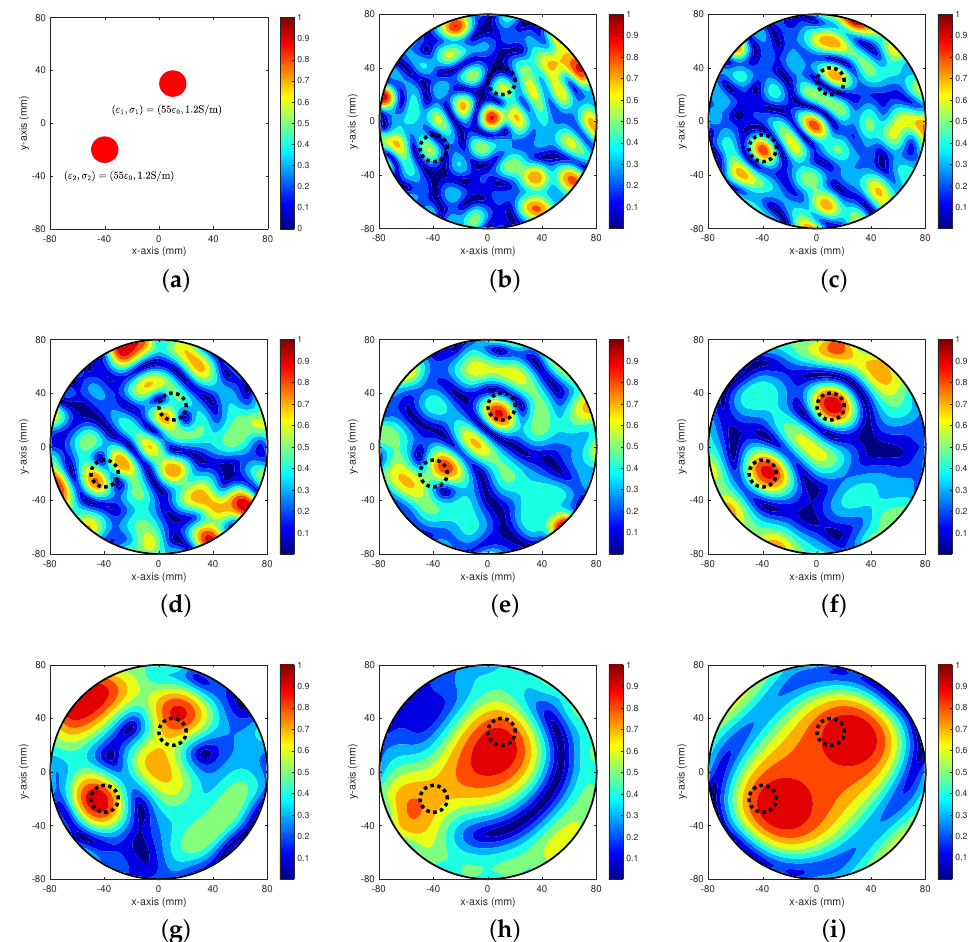
Figure 3. (Example 2) Maps of F BS ( r , n ) . Black-colored dashed lines describe the boundaries of ob- jectives. ( a ) Small objective, ( b ) n = 1, ( c ) n = 2, ( d ) n = 3, ( e ) n = 4, ( f ) n = 5, ( g ) n = 6, ( h ) n = 7, ( i ) n =